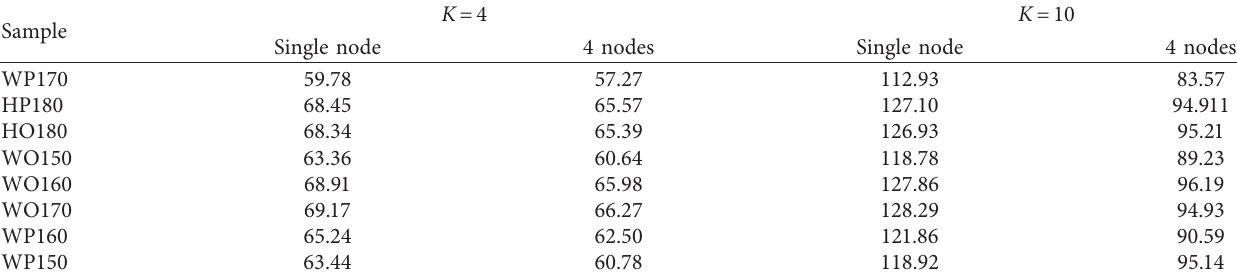
Table 12: Single node v/s multiple Hadoop nodes execution time (sec) for 3FT condition.